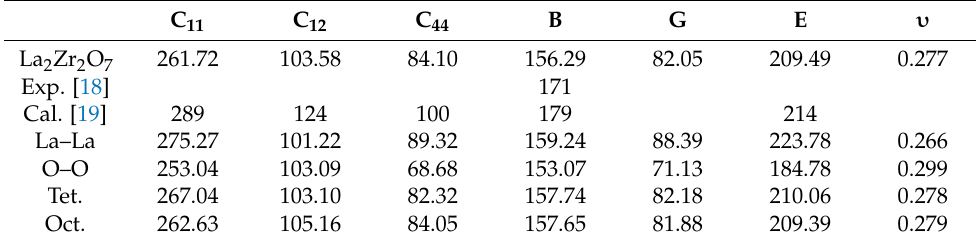
Table 2. Elastic constants (C 11 , C 12 , C 44 ), bulk modulus (B), shear modulus (G) and Young’s modulus (E) for He–La 2 Zr 2 O 7 . Here, a He atom is at the La–La (He atom at the midpoint of two lanthanum atoms), O–O (He atom at the midpoint of two oxygen atoms), Tet. (He atom at the tetrahedral location) and Oct. (He atom at the octahedral location) interstitial locations. The unit for all values is